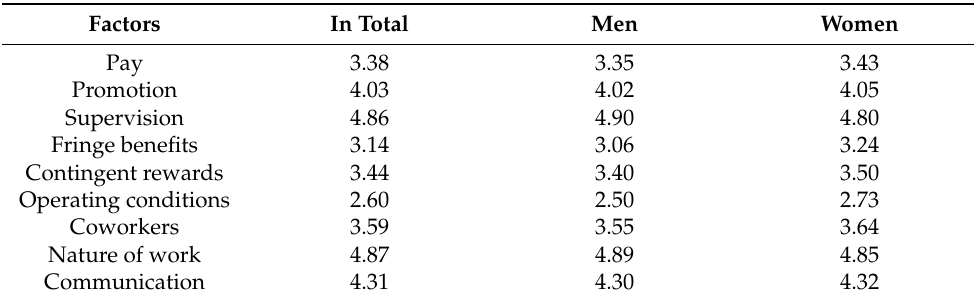
Table 2. Mean according to J.S factor.